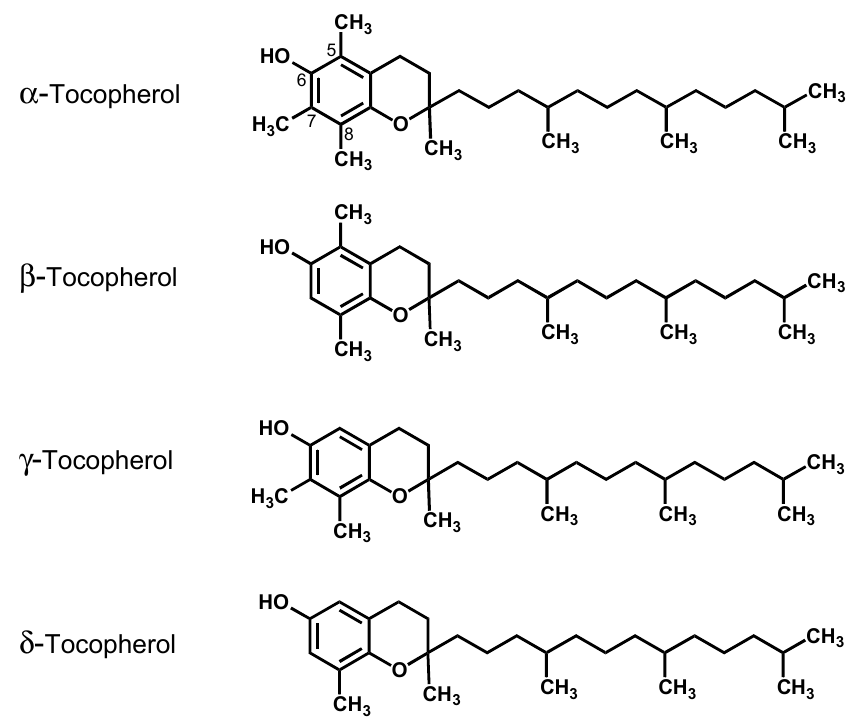
Figure 1. Chemical structures of α -, β -, γ -, and δ